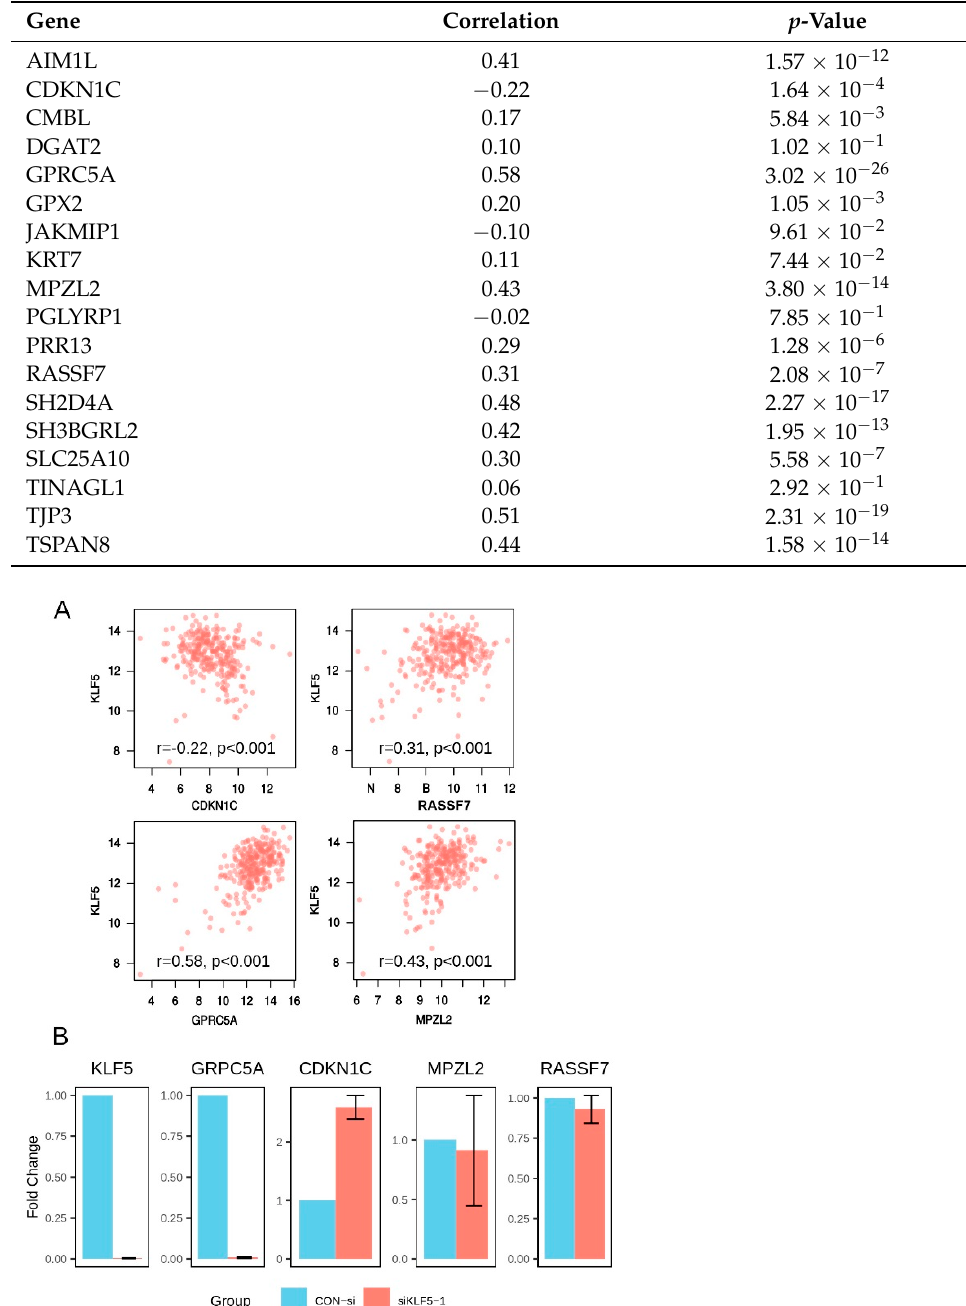
Figure 7. Screening and validation of potentially KLF5 regulated genes. ( A ) Scatter plots showing the correlation between the expression of KLF5 and selected genes in TCGA dataset. ( B ) qualitative PCR analysis of gene expression after transient downregulation of KLF5 using siRNA in SGC7901. KLF5 , GRPC5A , and CDKN1C showed statistically different expressions between siKLF5-1 and control treatment groups ( T -test: p < 0.05 for all three genes). The assay was repeated three times and one of the typical results was shown here.